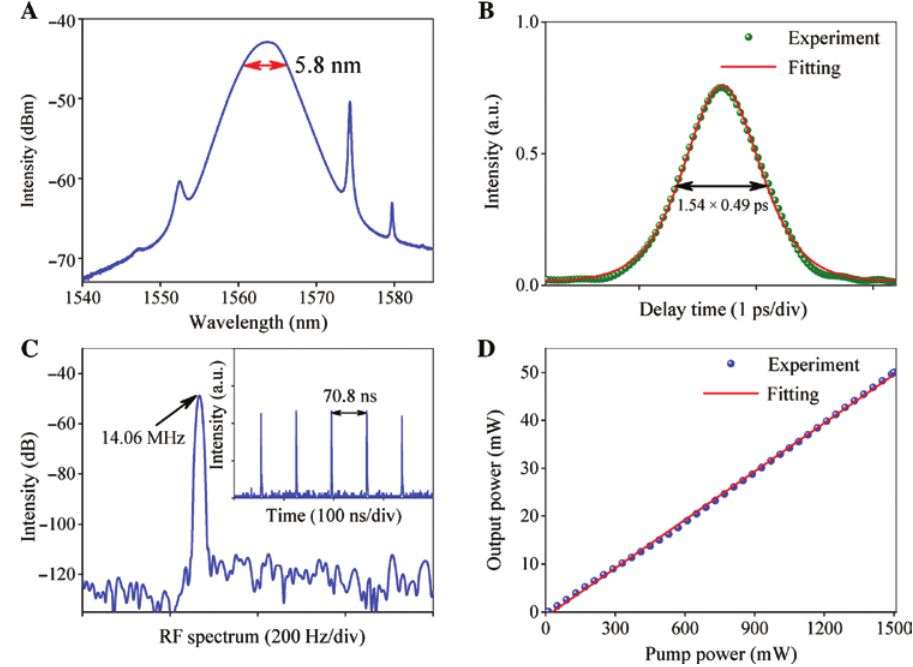
Figure 4: Performances of the DSF-PbSe mode-locked fiber laser. (A) Spectrum. (B) Auto-correlation trace. (C) RF spectrum, inset: pulse trains. (D) Output power vs. pump